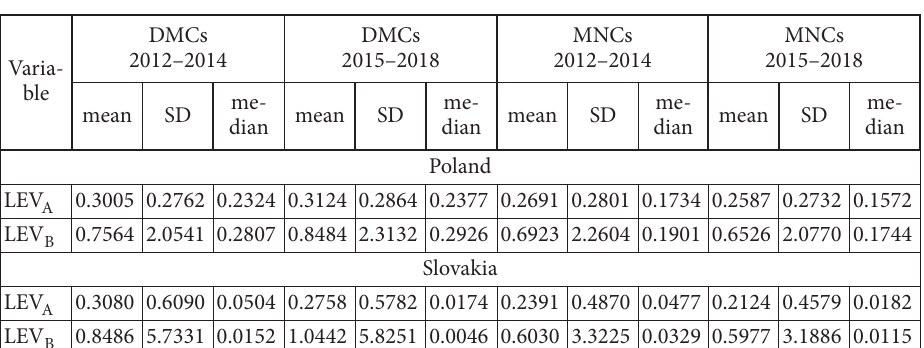
Table 9. The level of indebtedness 2012–2014 and 2015–2018: Poland and Slovakia